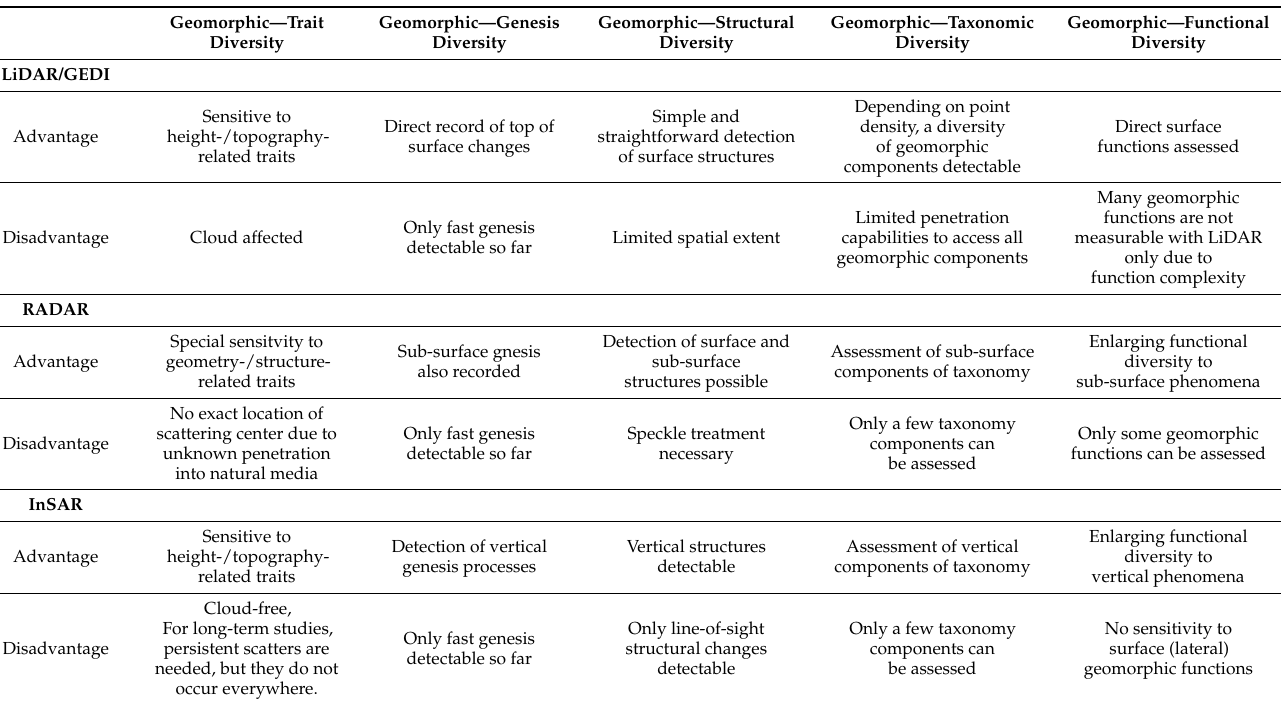
Table 1. Advantages and disadvantages of different RS imaging techniques regarding the five different geomorphic diversities: trait, genesis, structure, taxonomy, and